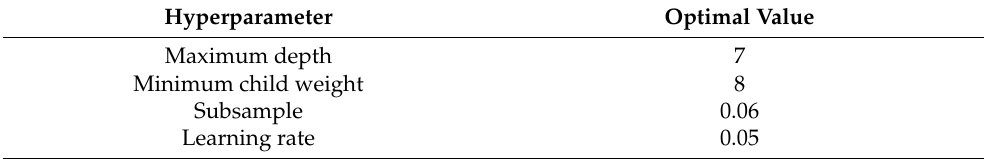
Table 6. Optimal hyperparameters for XGBoost mental health model for the EU+ total population. Hyperparameter Optimal Value